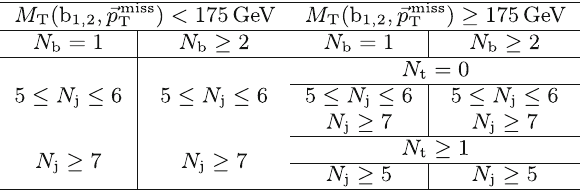
) , N j , N b , and N t used to T